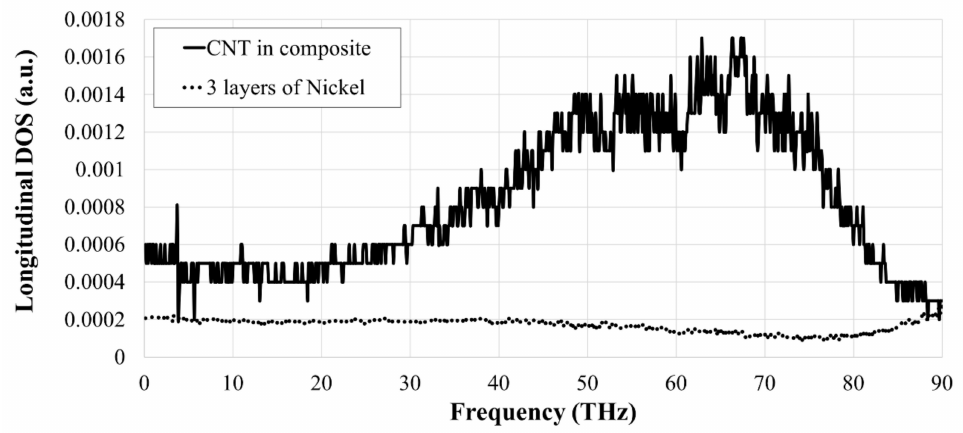
Figure 7. Separate PDOS curves for Carbon and Nickel atoms in the composite with three layers on